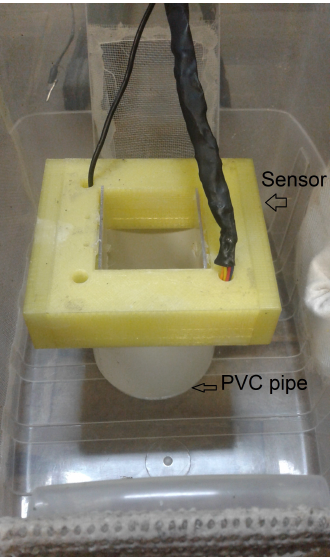
Figure 9. System used in the experiment to measure the signal of fruit flies, with the detail of the positioning of the PVC pipe and the sensor.